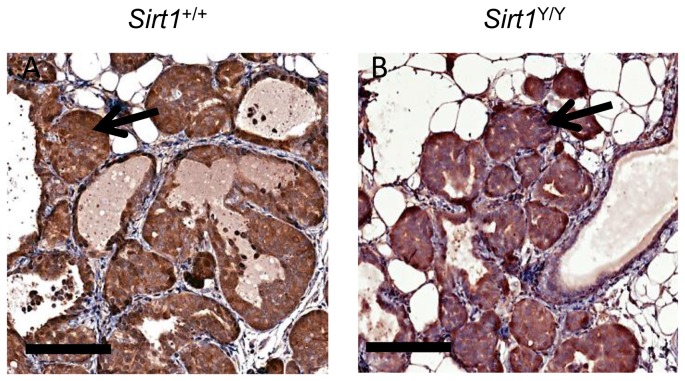
Loss of SIRT1 catalytic activity does not affect expression of the PyMT transgene.Representative immunohistochemical staining for Middle T Antigen in mammary glands of PyMT+/Sirt1
+/+ and PyMT+/Sirt1
Y/Y mice collected at 6 weeks of age (scale bars equal to 100 μm). Arrows indicate areas of mammary intraepithelial neoplasia.